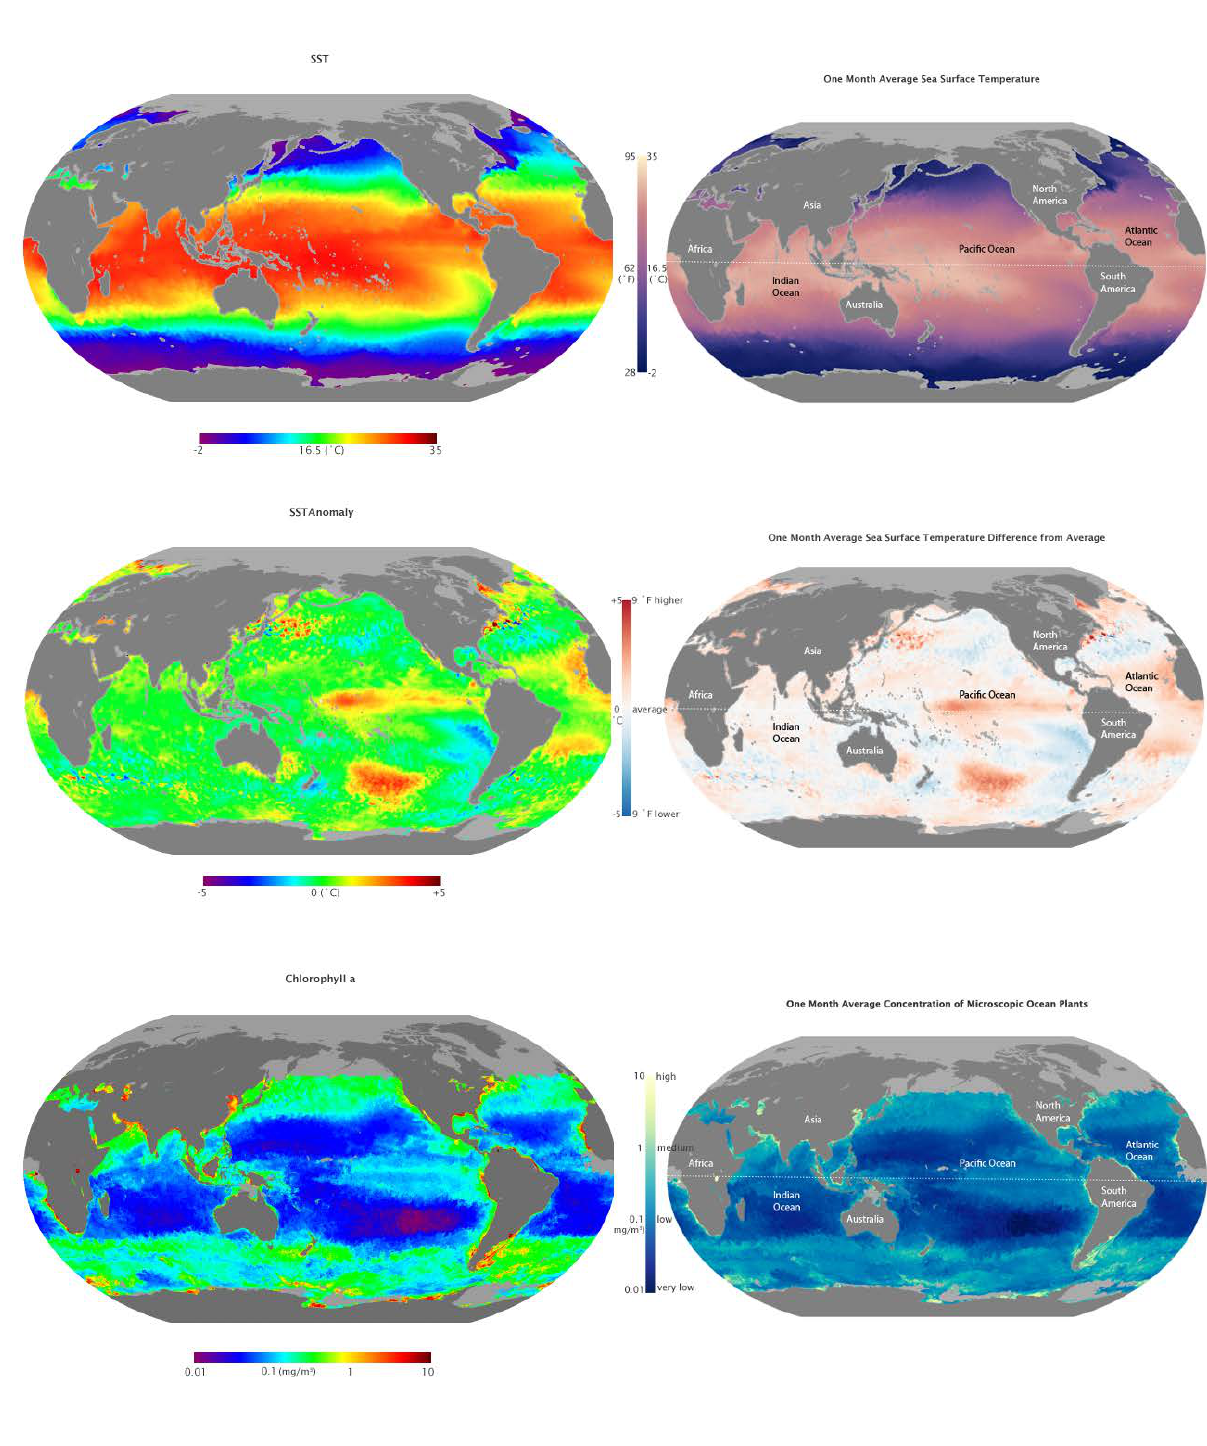
Appendix Figure 1. Unscaffolded and fully-scaffolded visualizations. Left (top to bottom): rainbow color scale ver- sions of Sea Surface Temperature (SST), SST Anomaly, and Chlorophyll. SST and Chlorophyll each show a single con- tinuous variable; SST Anomaly shows a diverging variable of higher-than-average and lower-than-average scales. Right: improved color schemes, titles and keys, and geographic labels for the